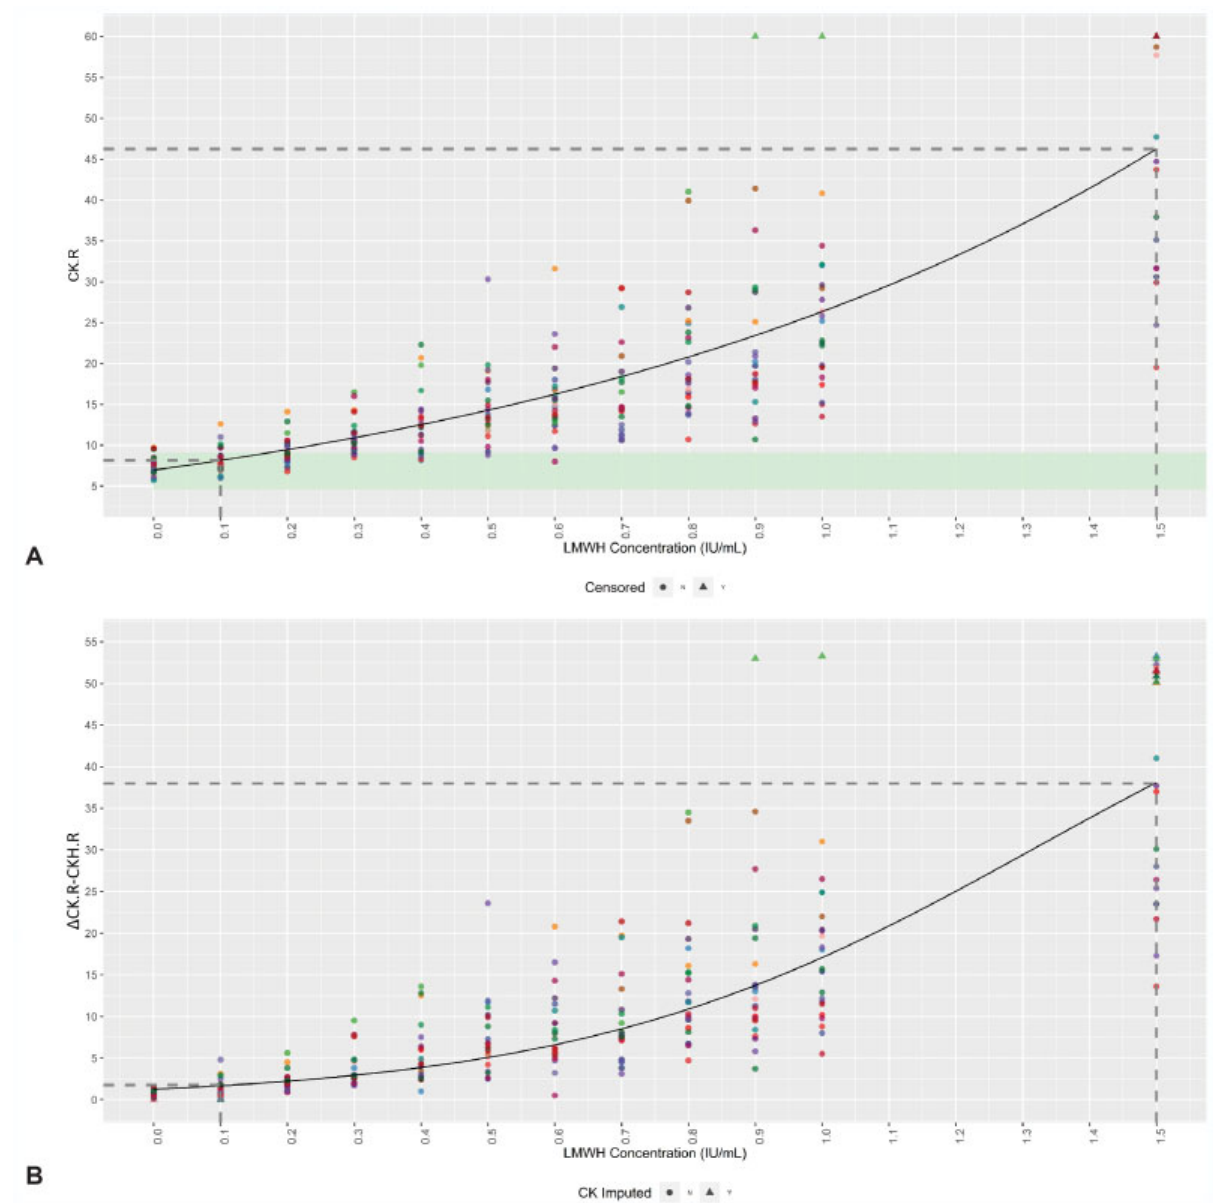
Fig.2 Concentration-dependenteffectsofLMWHontheTEG6sparameters.Mixed-effectfour-parameterlogisticmodelof( A )CK.R,( B ) Δ CK.R (cid:3) CKH.R,( C ) ratio CKH.R/CK.R, and ( D ) ratio CK.R/CKH.R in relation to the LMWH concentration. Individual donors are highlighted in different colors, with the model ( blackline )included.ReferencerangelimitsforCK.Rareshownin lightgreen .The dottedlines representtheminimumandmaximumvalues( fi rstdosewhere the responsewas statisticallysigni fi cant from thedose0 response orlast dosewherethe responsewas statisticallydifferent from the lastobserved dosein the model,respectively). Valuesgreater than60arebeyond thelimitofdetection, andsoare markedascensored. CK, kaolin; CKH,kaolinwith heparinase; LMWH, low-molecular-weight heparin; R, reaction